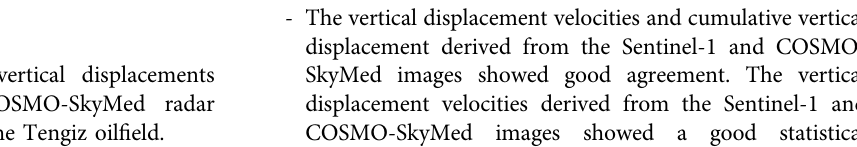
Frontiers in Environmental Science |